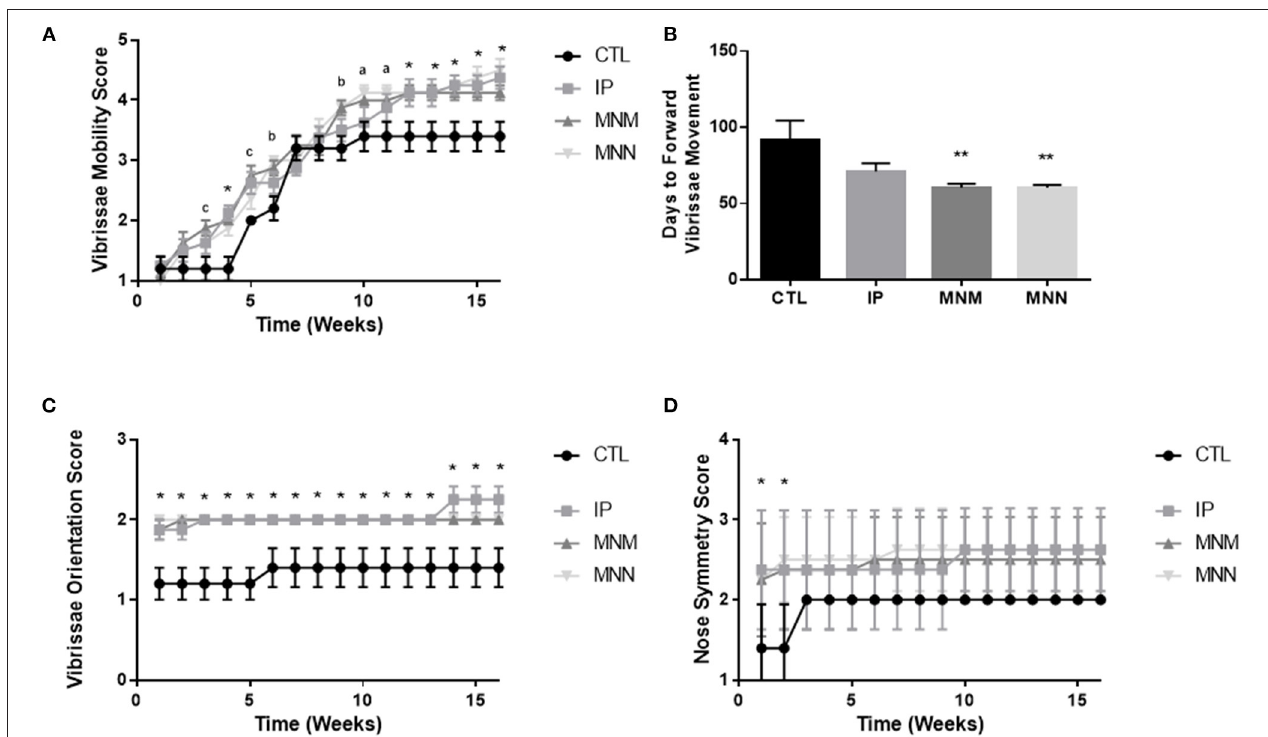
FIGURE 2 | Functional recovery results: weekly vibrissae movement scores (A) , number of days until each group achieved forward vibrissae movement (defined as a score of 4 or above) (B) , weekly vibrissae orientation scores (C) , weekly snout symmetry scores (D) . Data represented as Mean ± SEM (** p < 0.01 as compared to CTL, * p < 0.05 all groups compared to control, a p < 0.05 MNN alone as compared to CTL, b p < 0.05 MNM and MNN as compared to CTL, and c p < 0.05 MNN and IP as compared to